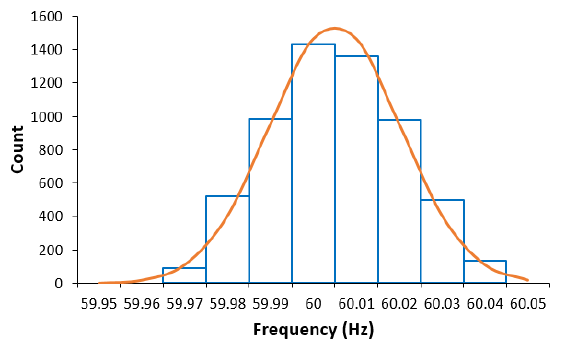
Figure 3. Histogram of frequency data collected from the input grid at the NRC campus at 08:30 for 100 min on 15 May 2018.